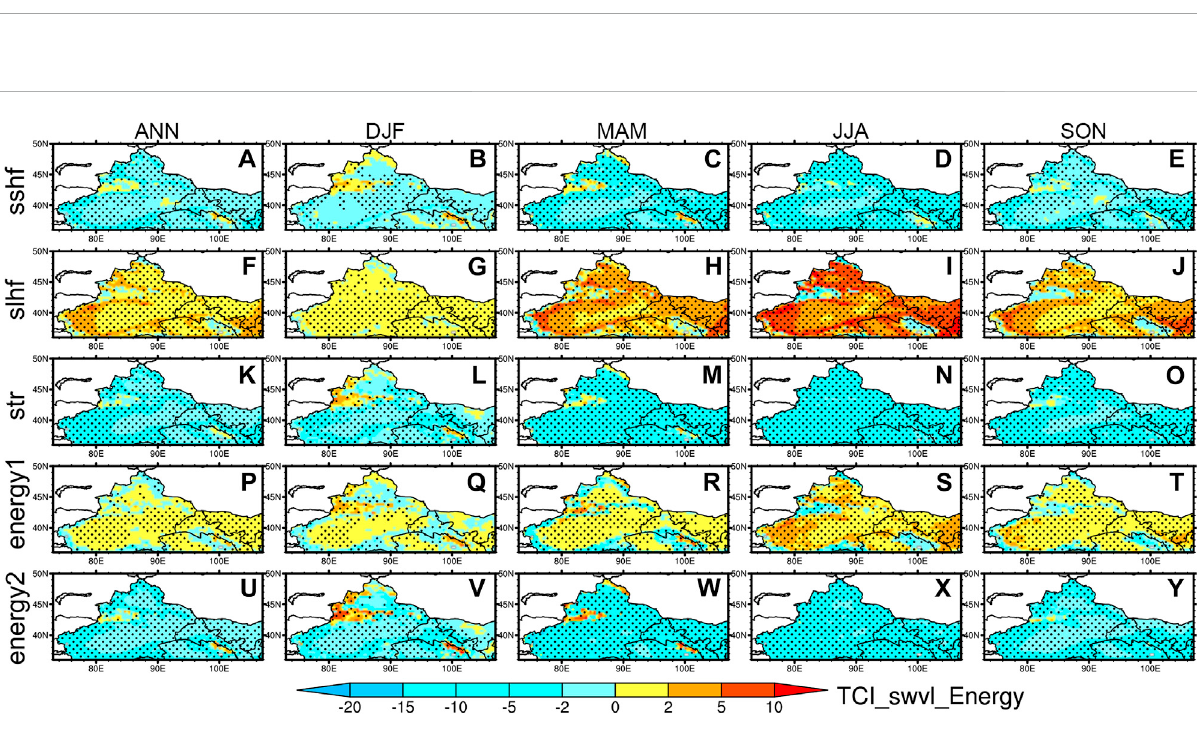
FIGURE 9 Spatial distributions of the annual and seasonal coupling index of swvl1 with sshf, slhf, str, energy1, and energy2. The rest of the caption is the same as in Figure 6.